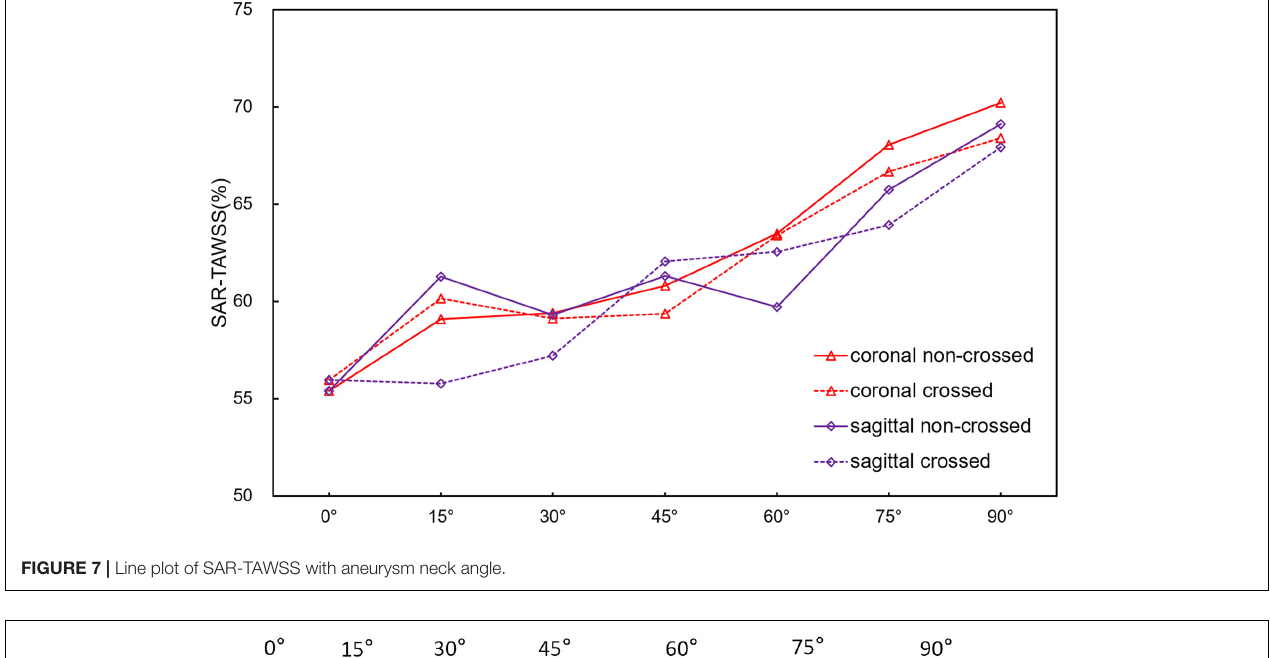
FIGURE 7 | Line plot of SAR-TAWSS with aneurysm neck angle.